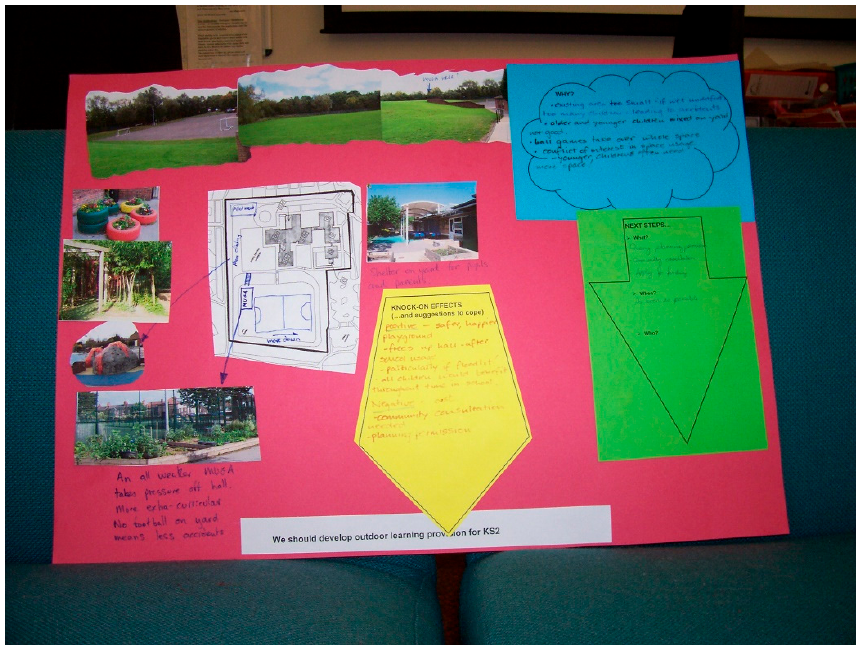
Figure 2. Collage presenting a priority for change and design suggestions from staff.